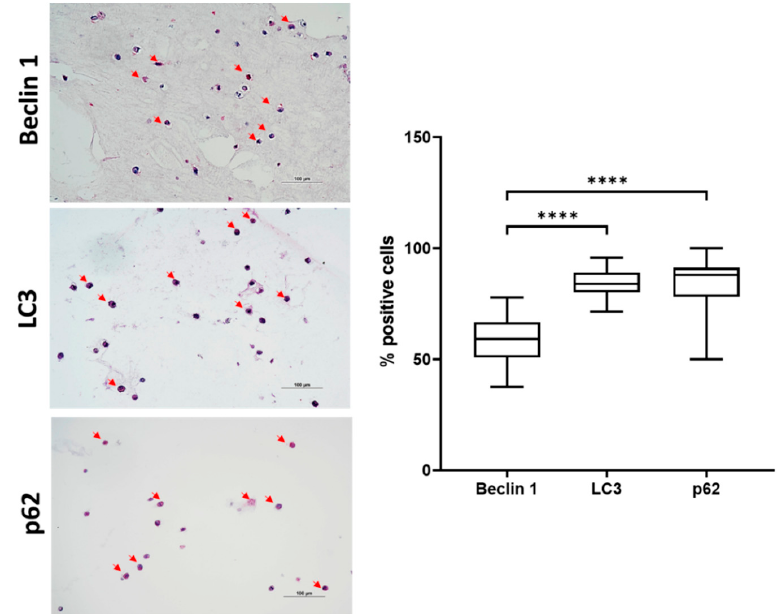
Figure 5. Immunohistochemical analysis of Beclin 1, LC3 and p62 proteins of hASCs embedded in VG-RGD hydrogel at day 2. Bar = 100 µm. Arrows indicate positive stained cells. Quantification of the percentage of positive cells. Data were expressed as percentage of positive cells and represented as a boxplot with median, minimum, and maximum. Kruskal–Wallis with Dunn’s multiple comparisons test was used for statistical analysis: * indicates differences between autophagic markers; **** p <